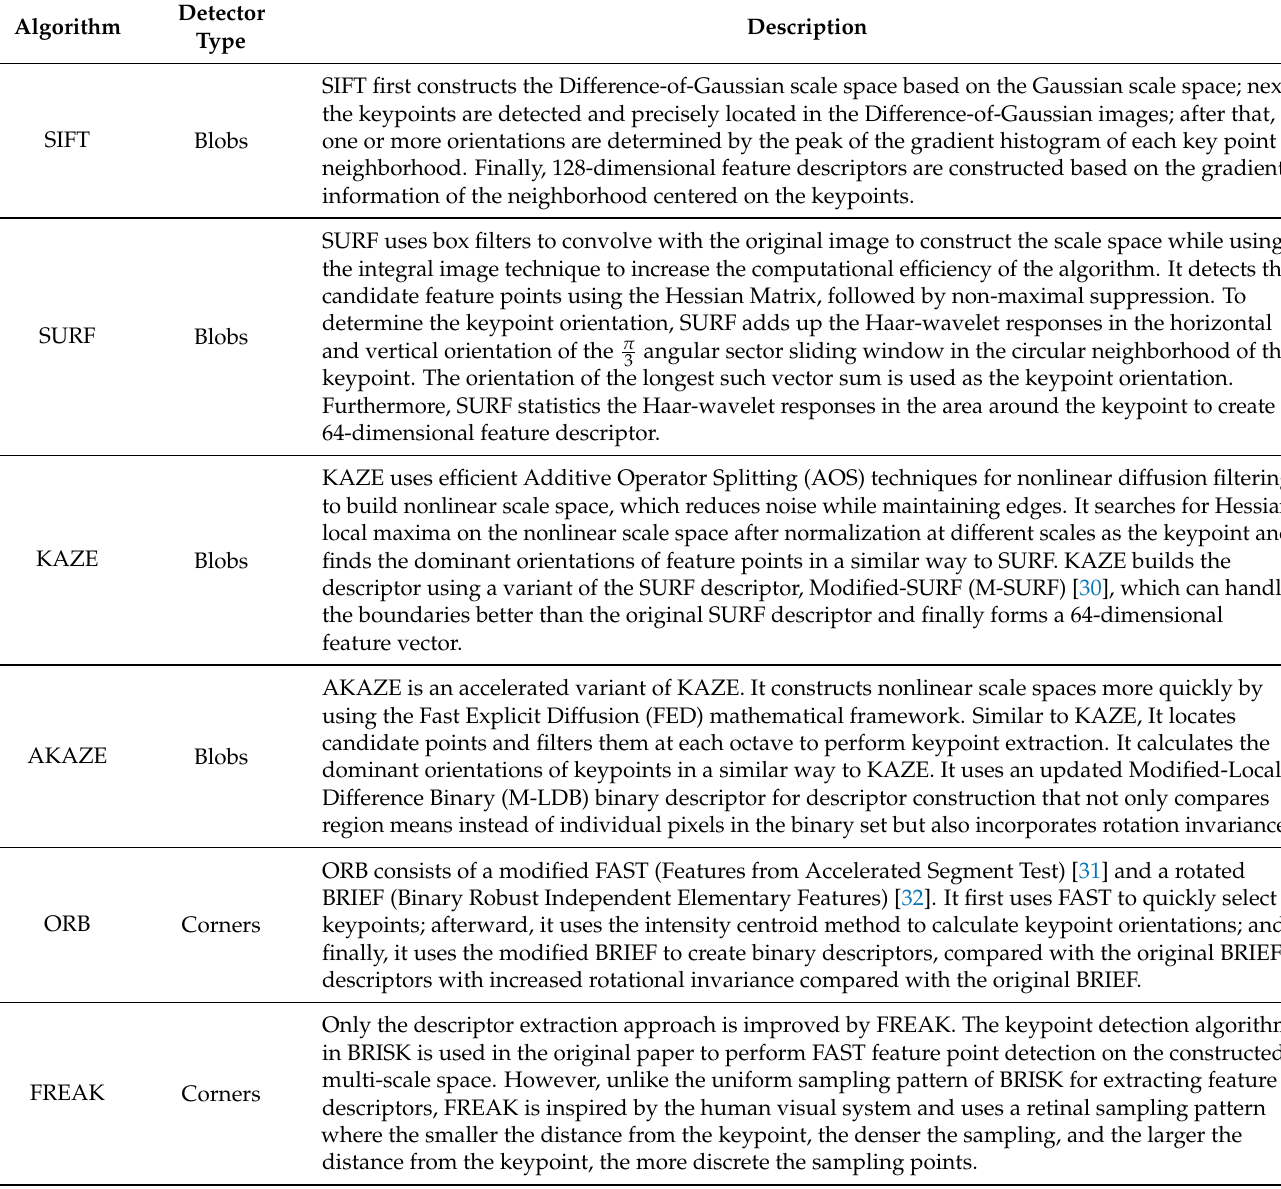
Table 1. Brief introduction of multiple local invariant feature algorithms.